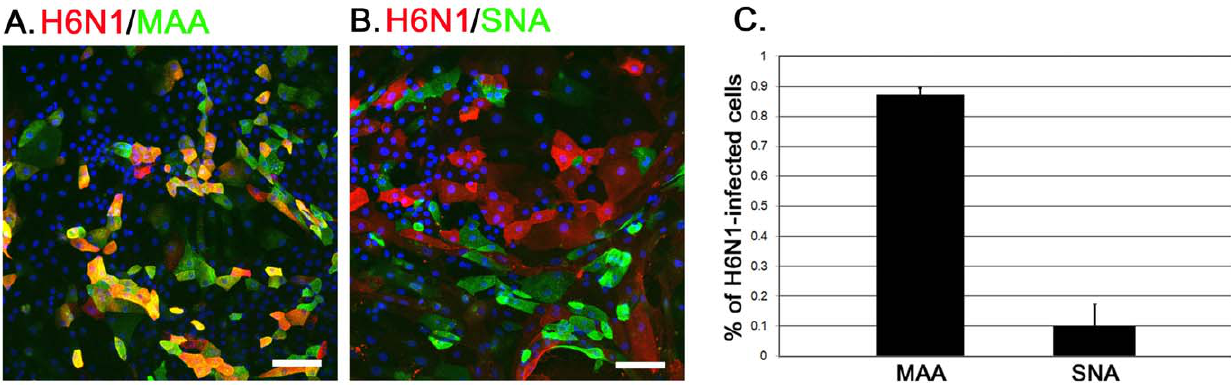
Figure 4. The SA expression on AIV H6N1 infected cells. A total of 5 6 10 4 CTE cells were infected with 0.5 m l of AIV H6N1 2838V (viral stock, EID 50 =10 8 /ml) at a MOI of 1 for 1 h at 37 u C. At 6 h.p.i., the expression of viral H6N1 proteins was detected by chicken serum against the AIV (1:500, red) (A, B). The ratio of MAA or SNA expression on the infected cells was manually counted from five individual fields (C). Scale bar in panel A, 100 m m; in panel B, 50 m m. doi:10.1371/journal.pone.0018894.g004 PLoS ONE |